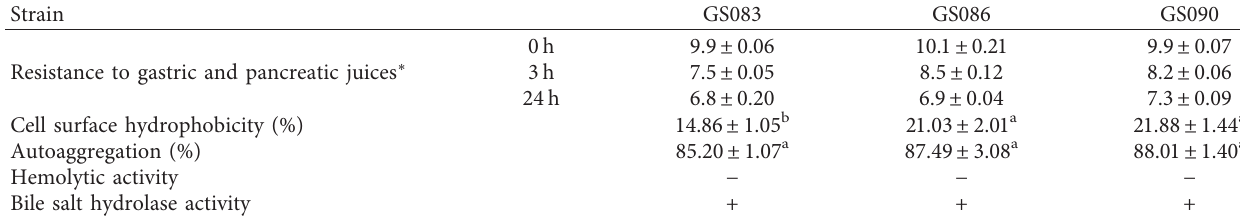
Table 4: Probiotic properties, hemolytic, and bile salt hydrolase activity of the selected strains.